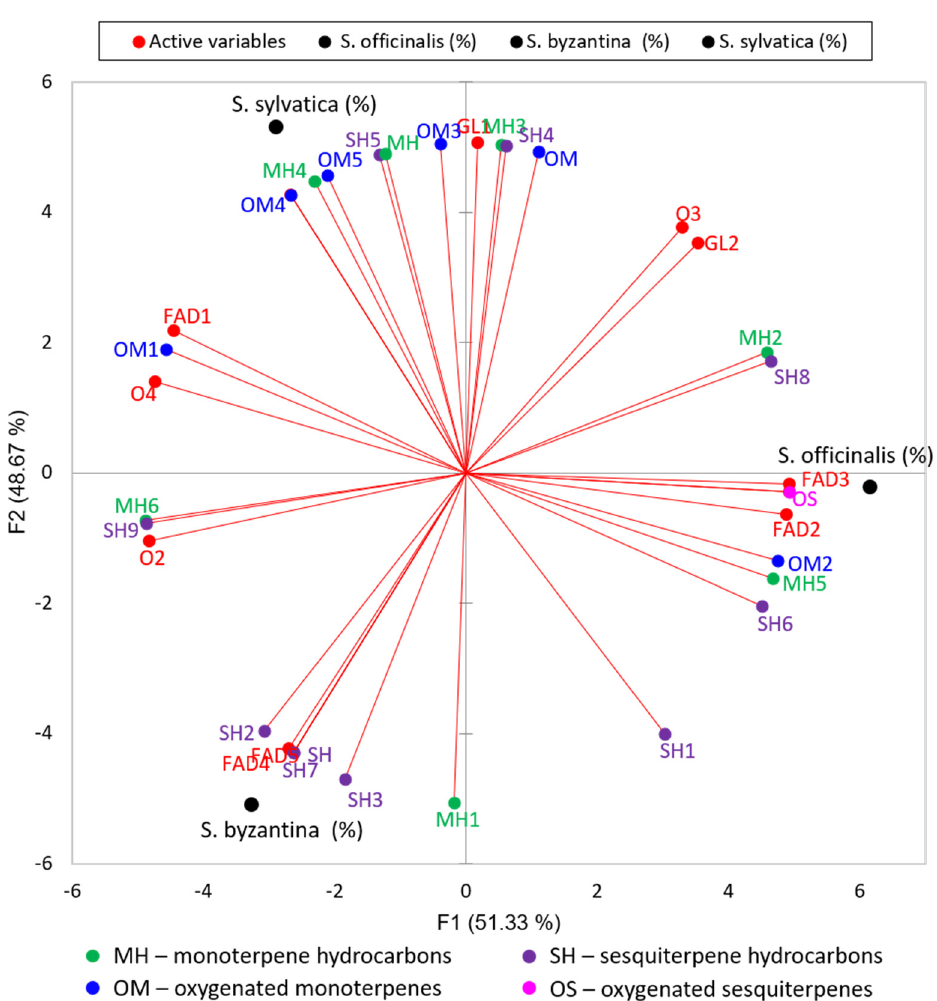
Figure 1. 2D-principal component analysis plot of the VOCs in the three Stachys species. FAD—fatty acids and fatty acid-derived compounds; GL—green leaf volatiles; MH—monoterpene hydrocarbons; OM—oxygenated monoterpenes; SH—sesquiterpene hydrocarbons; OS—oxygenated